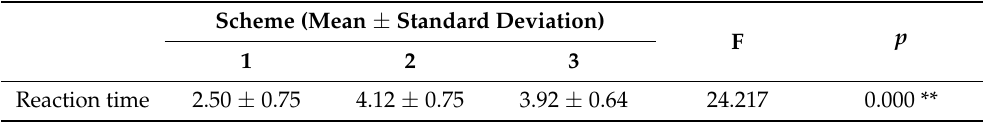
Table 5. The results of the analysis of